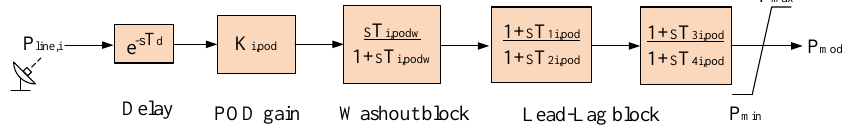
Figure 8. i th POD